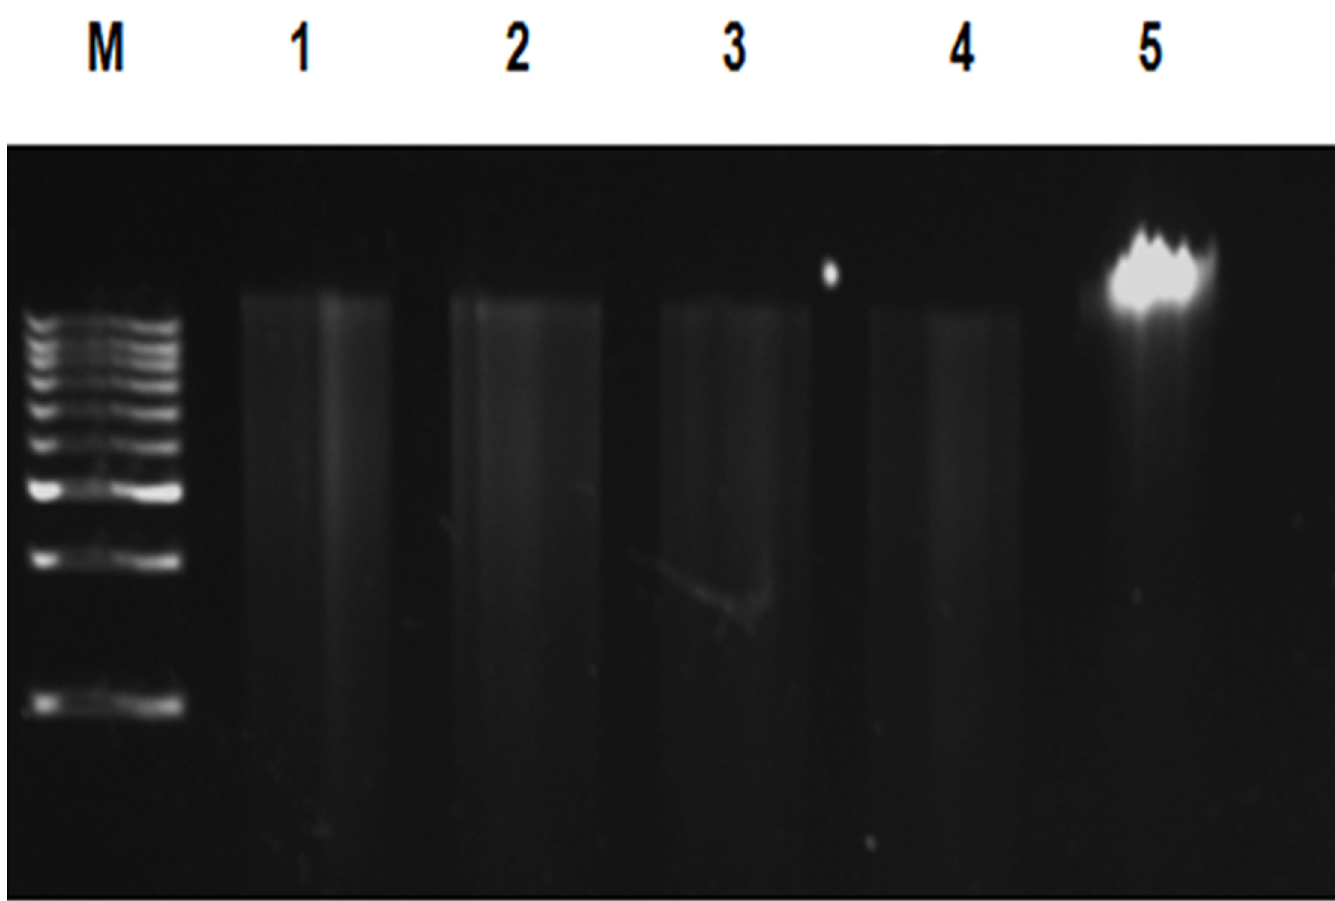
Fig 3. Gel electrophoresis of partial restriction digestion of the metagenomic DNA extracted by powdered glass method (M6) using Bam HI. Samples were analyzed on 0.8% agarose gel in 0.5X TBE buffer. Lane M: 1Kb DNA ladder (Merck, India); Lane 1: Garden soil; Lane 2: Sewage sludge; Lane 3: Lake soil; Lane 4: Compost. Lane 5: Undigested DNA.